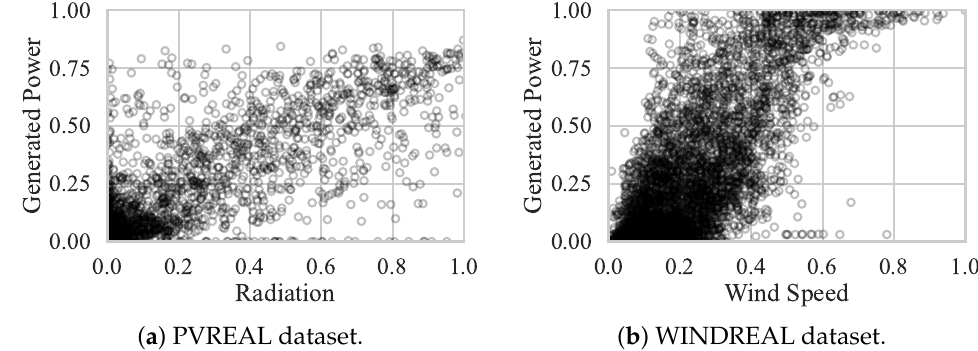
Figure 6. Scatter plots of the most relevant features for power forecasts from day-ahead weather forecasts and the historical power measurements. Large radiation or wind speed values and no power generation indicate an incorrect weather forecast or feed-in management. Large power generation values and a low value of wind speed or radiation indicate an incorrect weather